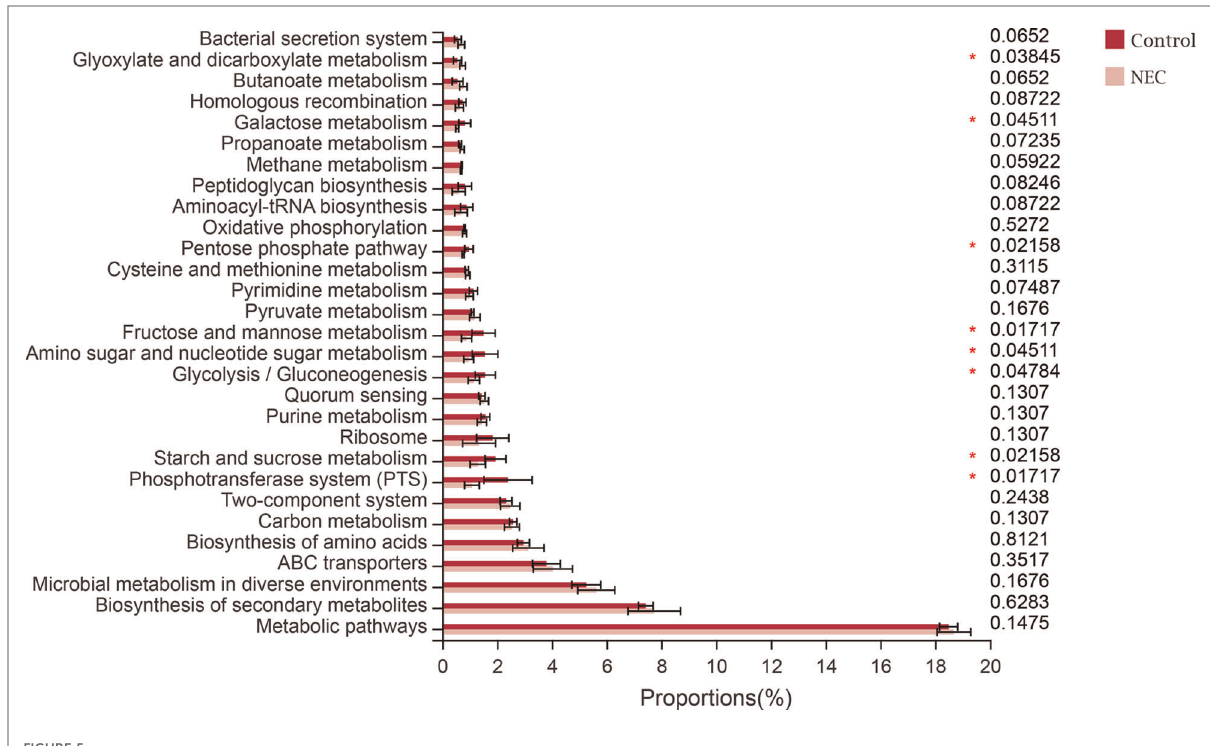
FIGURE 5 PICRUSt2 analysis of the abundance of the top 30 KEGG